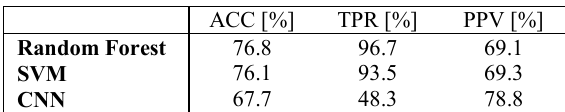
Table 2 . Classifier performance.